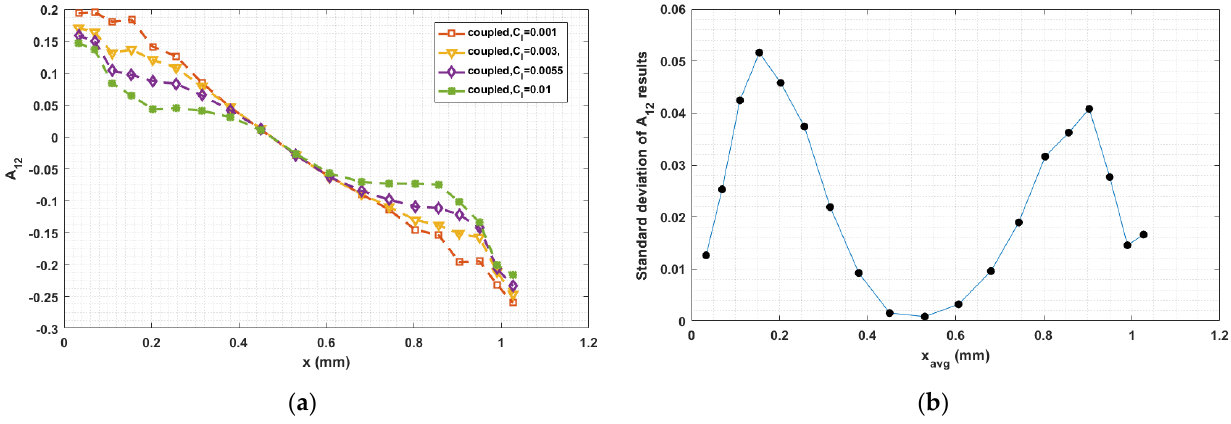
Figure 20. ( a ) Fiber orientation tensor component A 12 at nozzle exit; ( b ) standard deviation of the parametric study resulted A 11 versus the averaged x locations.